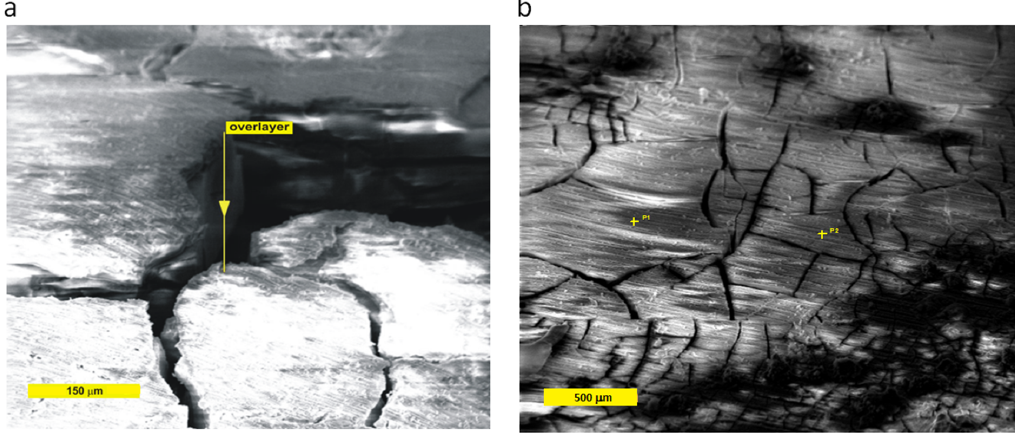
Figure 6. Typical low-magnification SEM images of cracks in the scaled degradation layer in sample X03 at higher ( a ) and Z5 at lower ( b ) magnification after immersion in the SBF.